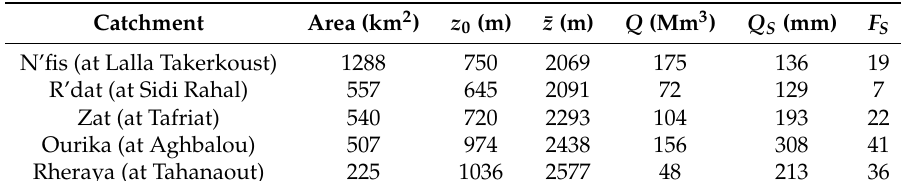
Table 1. Characteristics of the five main tributaries of the Tensift River in the High Atlas. z 0 : elevation